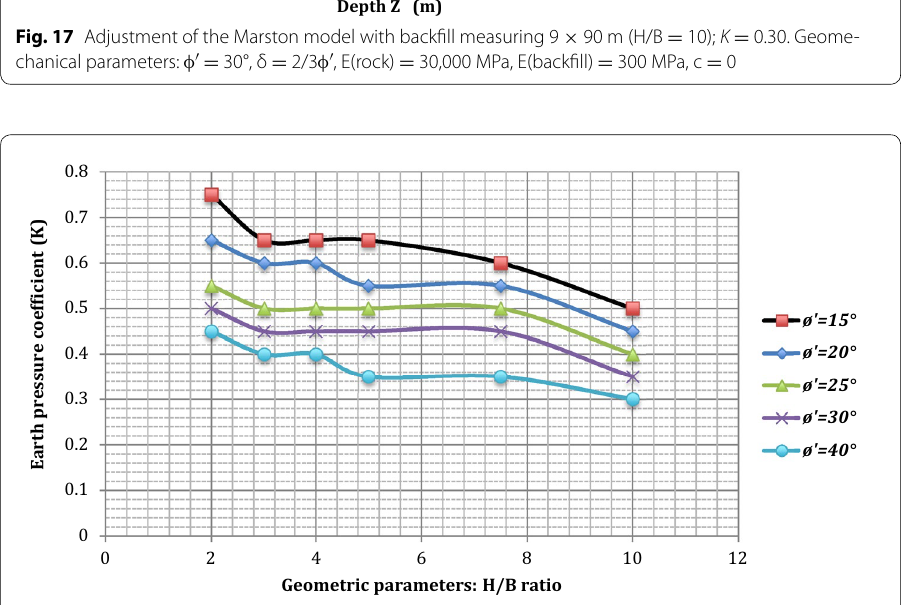
Fig. 18 Variation of K as a function of the H/B ratio and φ ′ . In this case, δ